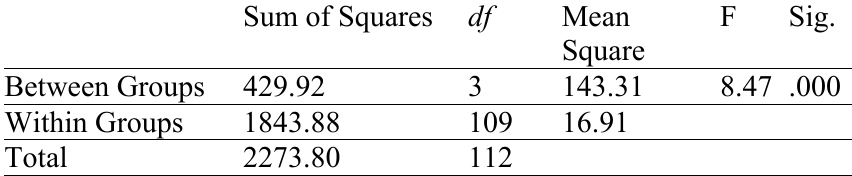
One-Way ANOVA Results of Production by Groups Sum of